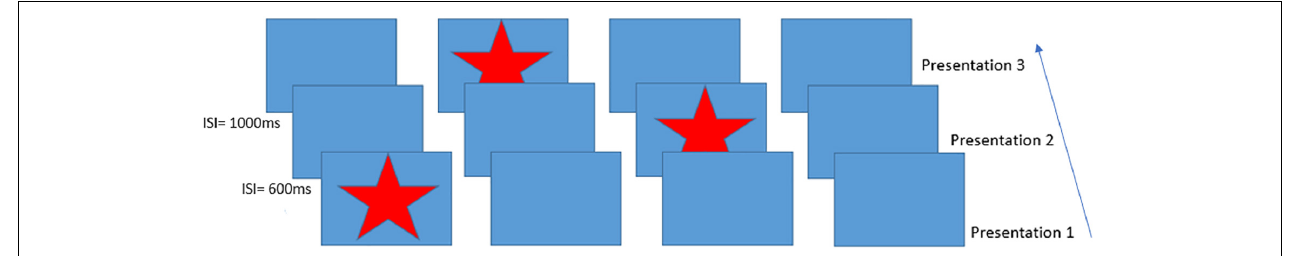
FIGURE 1 | Schematic of the Serial Reaction Time task presentation, inter-stimulus intervals on the left indicate example times between trials. This figure shows an example of the presentation of the first three items of the 12-item sequence. Participants responded to each star position using a handheld 4-button response box.